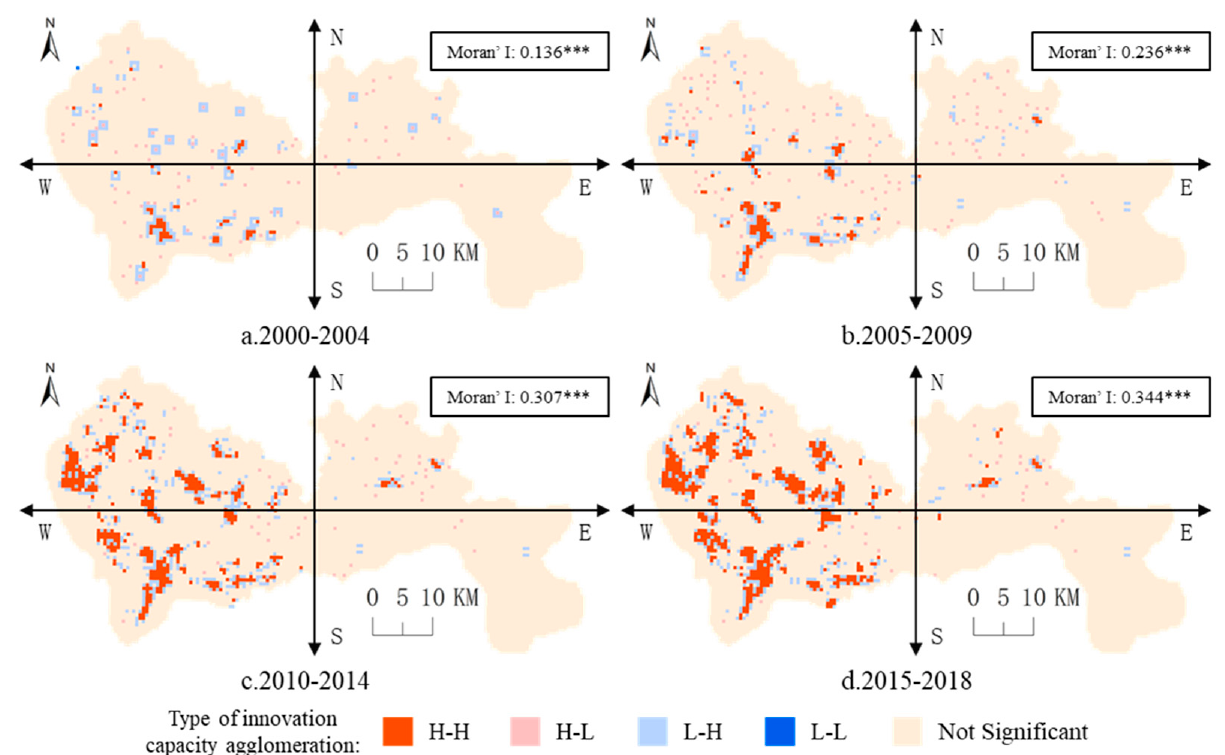
Figure 2. Evolution of the innovation agglomeration pattern of the secondary industry in Shenzhen from 2000 to 2018.